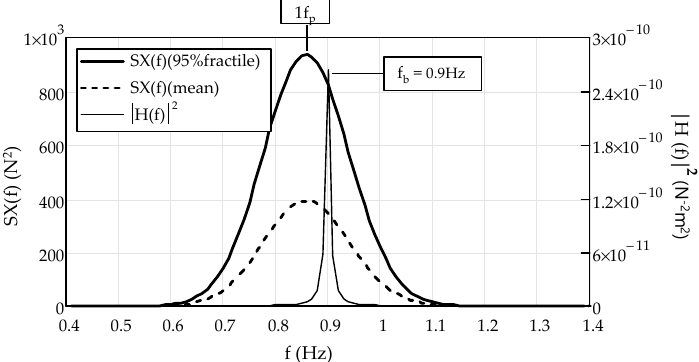
Figure 6. The functions SX(f) ( L = 144 m and Ld = 87.5 m) and H(f ) 2 ( f b = 0.9 Hz, M = 165,880 kg, K = 5,304,000 Nm − 1 and C = 10,880 Nsm − 1 [18]) are shown overlapped to represent Equation (15).